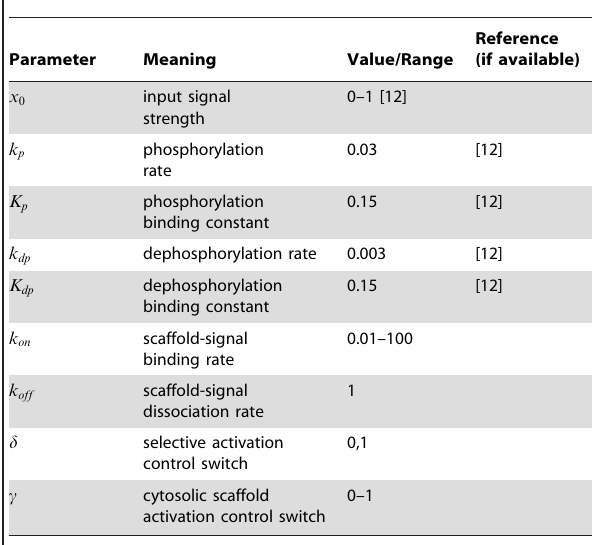
Table 4. Parameter listing for model (2).